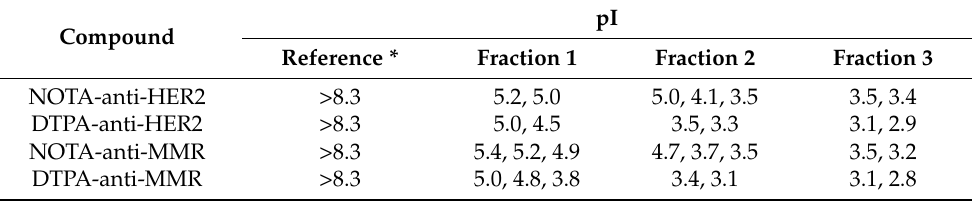
Table 2. Determination of isoelectric point by IEF gel. Compound